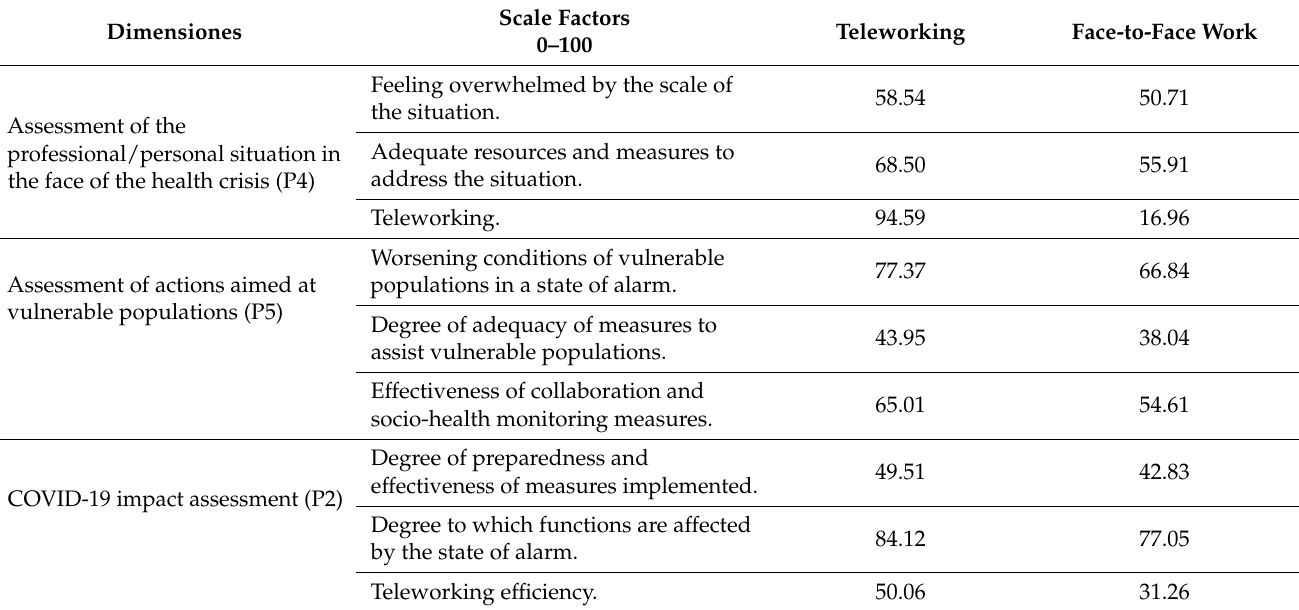
Table 6. Workers’ perception according to whether they work in person or telematically.